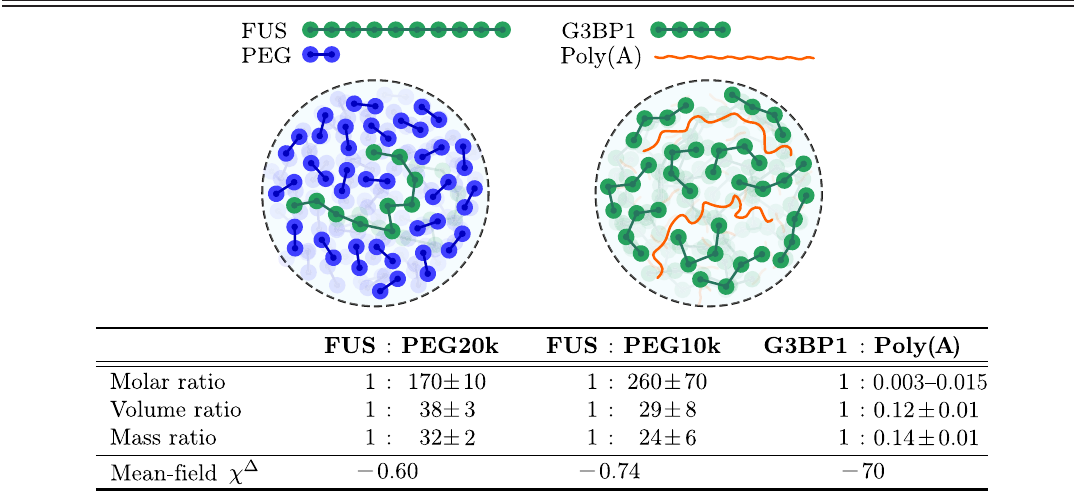
TABLE I. Summary of ratios of components in condensates in different units and cross-interaction energies χ Δ . PEG and G3BP1 are the main polymeric components in FUS-PEG and G3BP1-RNA condensates respectively. χ Δ estimates show FUS-PEG and G3BP1-poly(A) interactions are weakly and strongly attractive,